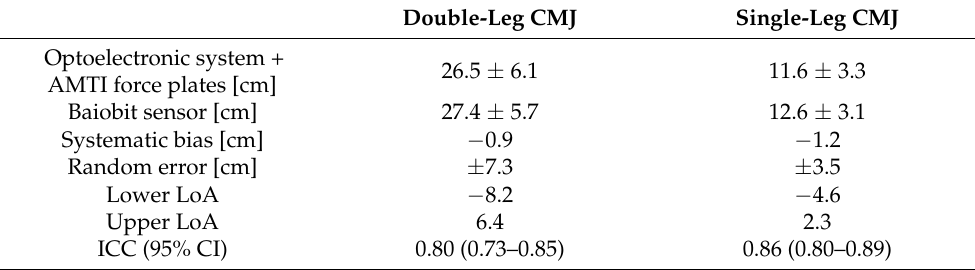
Table 4. Validity of the optoelectronic system and AMTI force plates and Baiobit sensor for jump